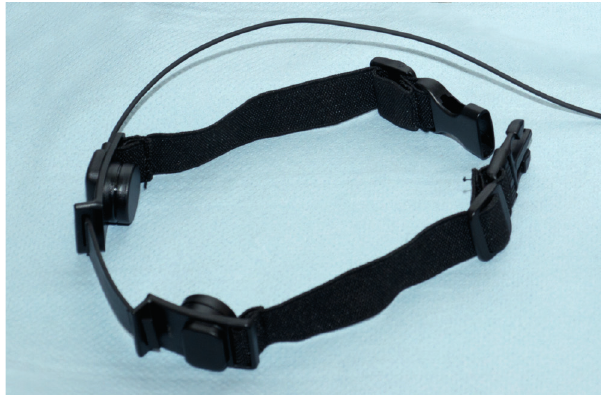
Figure 1. Contact microphone (CTH100, Clockaudio Ltd., Waterlooville, UK), utilized for high signal-to-noise ratio clinical recordings of snoring audio